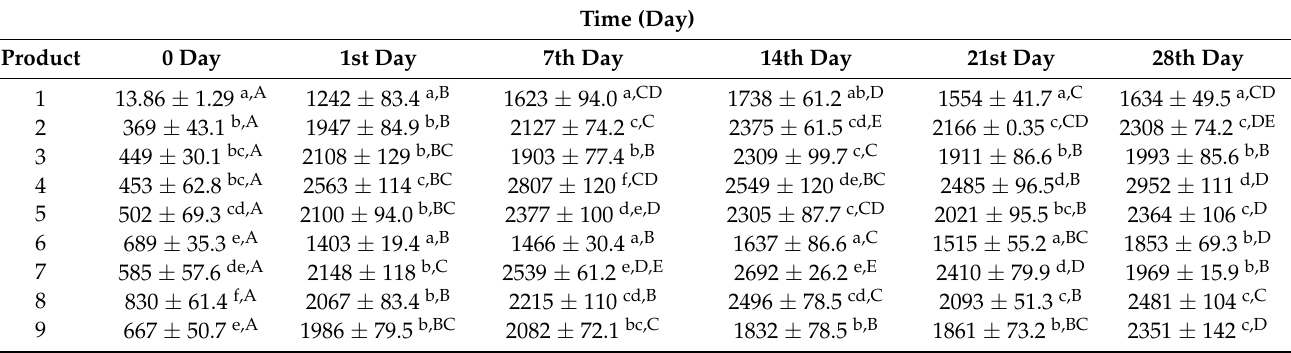
Lower case letters show statistical difference among samples at each time at α = 0.05 level. Capital letters show difference among time at each product at α = 0.05 level. 1: 0.02 g KC (control), 2: 0.02 g KC + 0.03 g YC + 0.06 g B. lactis , 3: 0.02 g KC + 0.03 g YC + 0.06 g B. lactis + 0.2 g GA, 4: 0.02 g KC + 0.03 g YC + 0.06 g B. lactis + 0.03 g FM, 5: 0.02 g KC + 0.03 g YC + 0.06 g B. lactis + 0.05 g FM, 6: 0.02 g KC + 0.03 g YC + 0.06 g B. lactis + 0.1 g FM, 7: 0.02 g KC + 0.03 g YC + 0.06 g B. lactis + 0.2 g GA + 0.03 g FM, 80.02 g KC + 0.03 g YC + 0.06 g B. lactis + 0.2 g GA + 0.05 g FM, 9: 0.02 g KC + 0.03 g YC + 0.06 g B. lactis + 0.2 g GA + 0.1 g FM). Abbreviations: KC: control